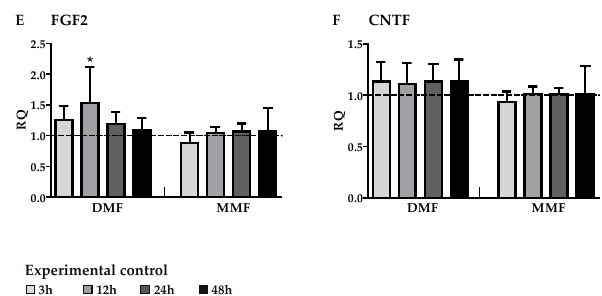
Figure 1. Gene expression of neurotrophic factors and growth factors in astrocytes treated with dimethylfumarate (DMF) or monomethylfumarate (MMF). Astrocytes were treated with medium, 10 µM DMF or 10 µM MMF for 24 h. Graphs show mRNA expression fold changes of NGF ( A ), BDNF ( B ), GDNF ( C ), PDGFa ( D ), FGF2 ( E ), and CNTF ( F ) after 3, 12, 24 or 48 h compared to the control group (astrocytes only treated with medium) and normalized with HPRT-1 using the ΔΔ CT method. Data are presented as the arithmetic means ± SEM of n = 3–6. Significant differences are marked by asterisks (* p < 0.05; ** p < 0.01; *** p < 0.001). Brain Sci. 2019 , 9 , x FOR PEER REVIEW